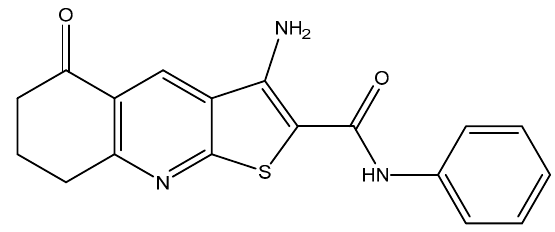
Figure 1. The structure of the anticancer thieno[2,3- b ]pyridine 1 (3-amino-5-oxo- N -phenyl-5,6,7,8- tetrahydrothieno[2,3- b ]quinoline-2-carboxamide).